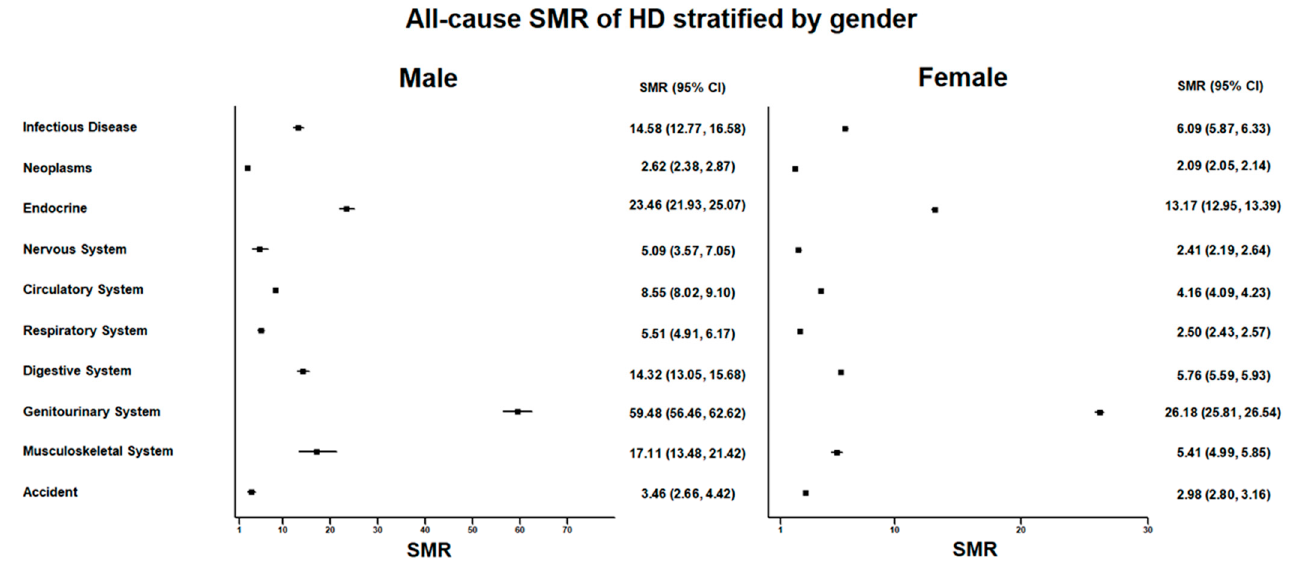
Figure 3. Observed death number of hemodialysis (HD) stratified by gender.